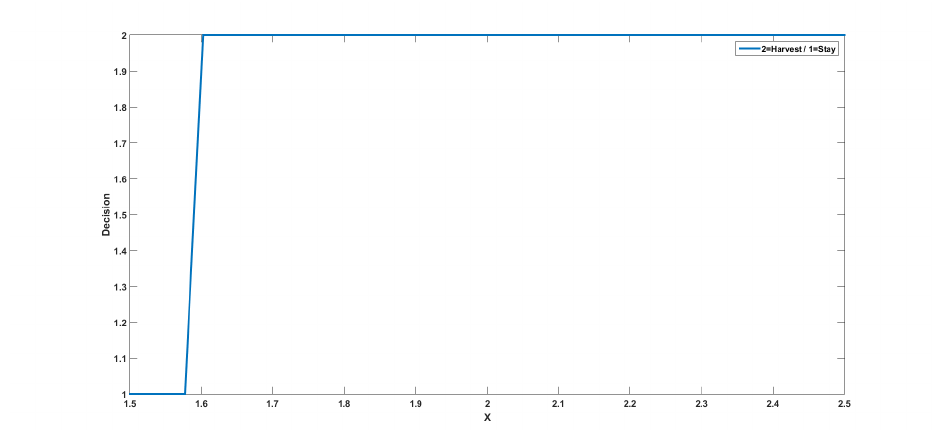
Figure 6. The optimal policy for ( x , p , θ ∈ [ δ , θ max ] , ρ , y ) ∈ D 2 in the plane of x